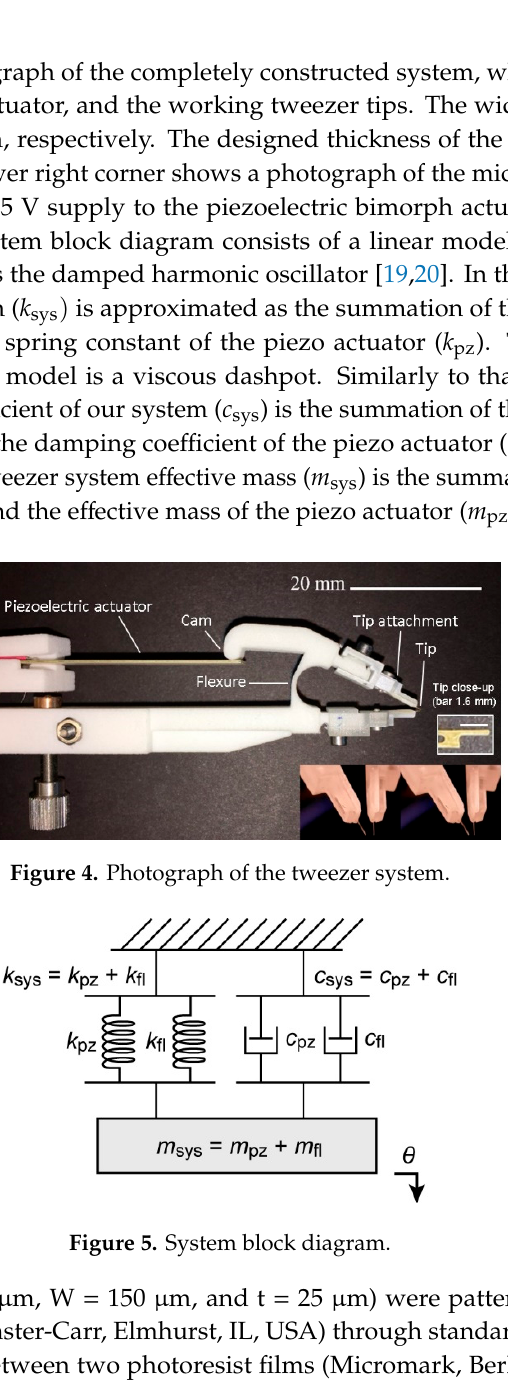
Figure 3. Principle of the displacement transmission mechanism. The cam is designed for θ to be linearly correlated to d . ( a ) The moving arm of the tweezers is supported by a flexure and actuated by a piezo bimorph actuator. ( b ) The curve of the cam is given as a path traced by the point of contact. ( c ) Piezo bimorph actuator works in a similar way to a bimetal cantilever ( d ) The cam is approximated as a circle in the actual 3D design (see supplementary Video S1).